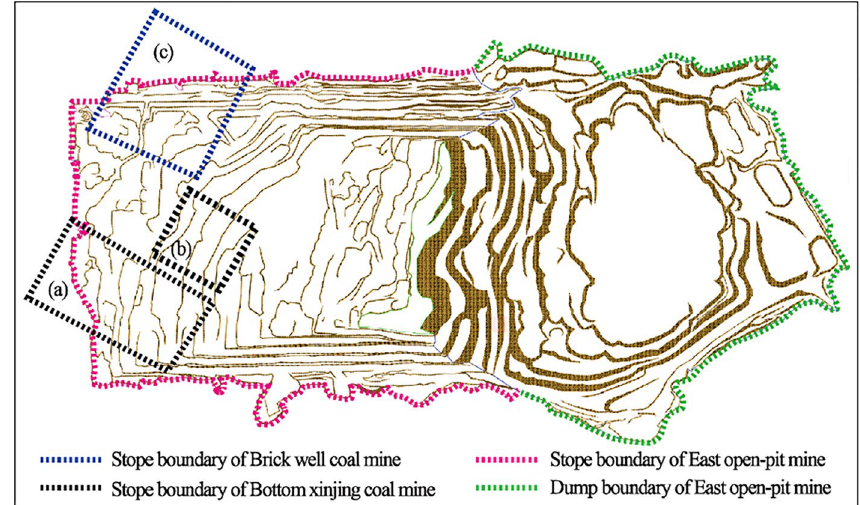
Figure 2. Distribution map of mined-out area of small kiln in the first mining area of East open-pit Mine (3DMine Mining Engineering Software Version 11.6): ( a , b ) Stope boundary of Bottom xinjing coal mine; ( c ) Stope boundary of Brick well coal